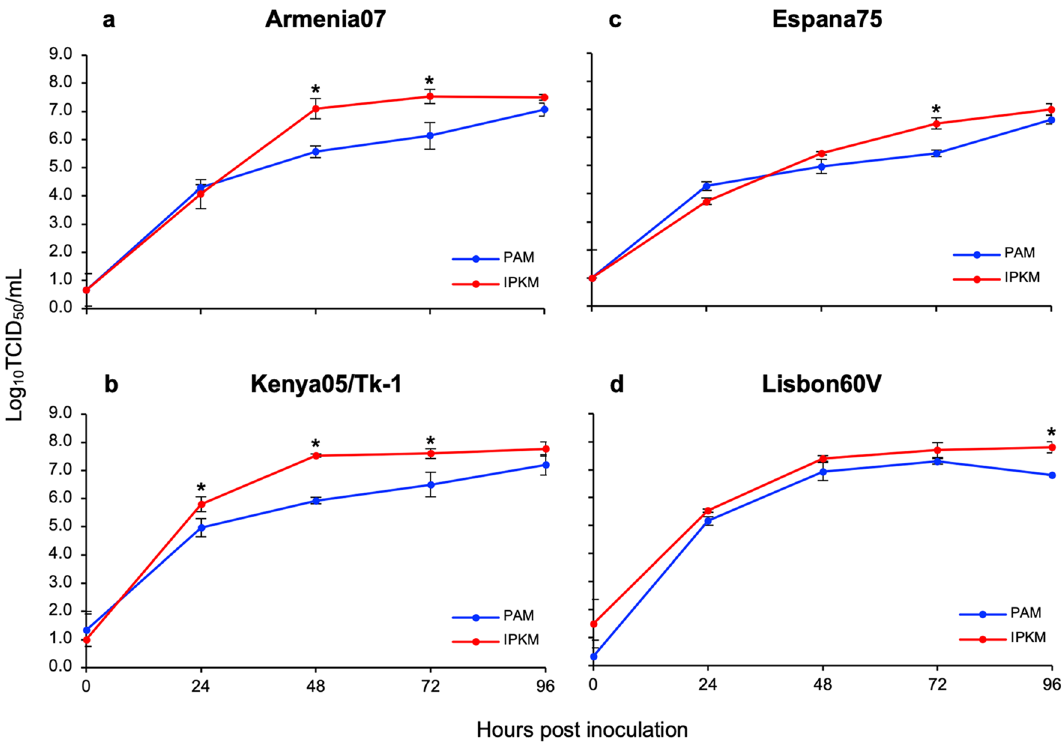
Figure 4. Comparison of the African swine fever virus (ASFV) production in primary porcine alveolar macrophages (PAM) and immortalized porcine kidney macrophages (IPKM). Cell cultures were infected with Armina07 ( a ), Kenya05/Tk-1 ( b ), Espana75 ( c ) and Lisobon60V isolates ( d ) (MOI = 0.001). The culture supernatant was recovered at the indicated time-point infection. Viral production in the PAM and IPKM cell cultures were estimated by titration. Data represent the means and standard deviations of three experiments. Asterisks indicate statistically significant differences in viral production in the PAM and IPKM cell cultures ( p < 0.05, Student’s t